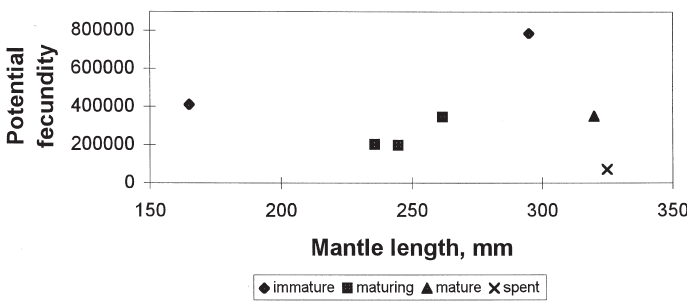
Fig. 3. – Potencial fecundity in A. atlantica , A. pfefferi and A. lesueurii